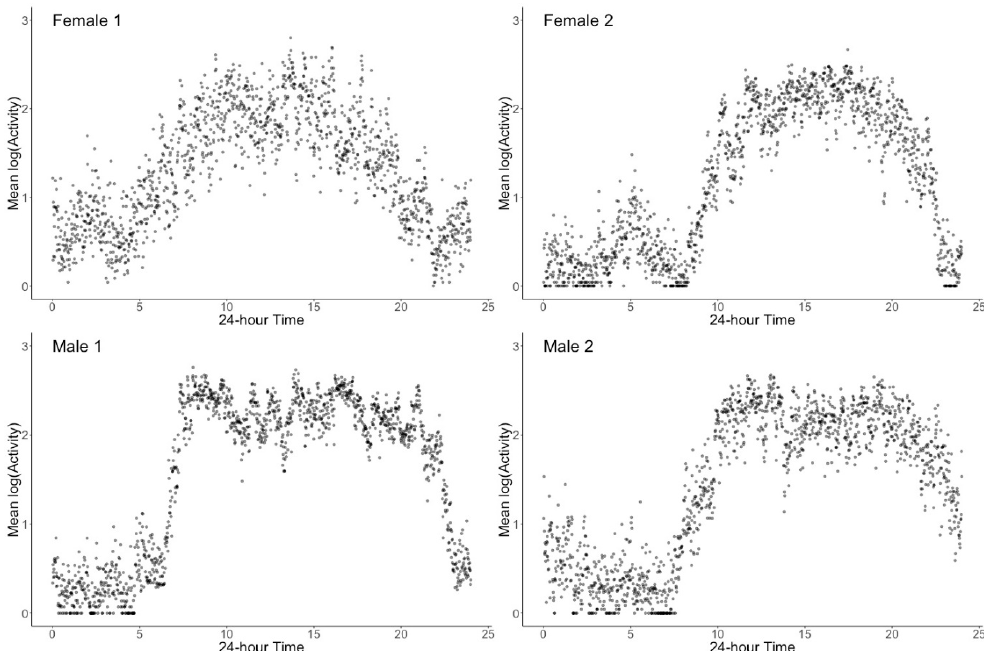
Figure 1. Example illustration of activity patterns of four older adults aggregated from